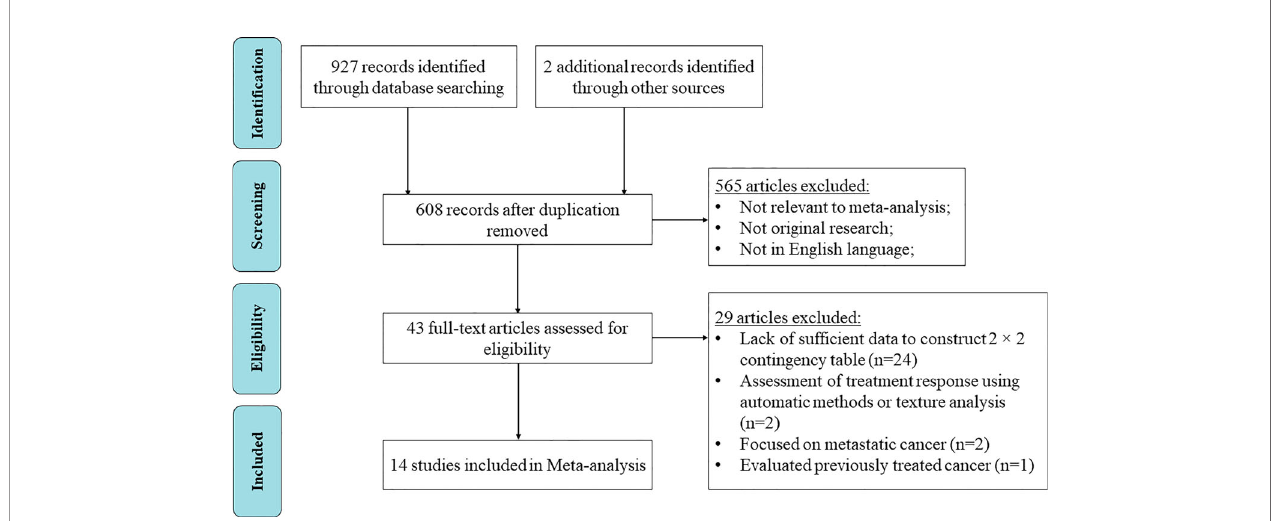
FIGURE 1 | Preferred Reporting Items for Systematic Reviews and Meta-Analyses (PRISMA) fl ow diagram for article identi fi cation and